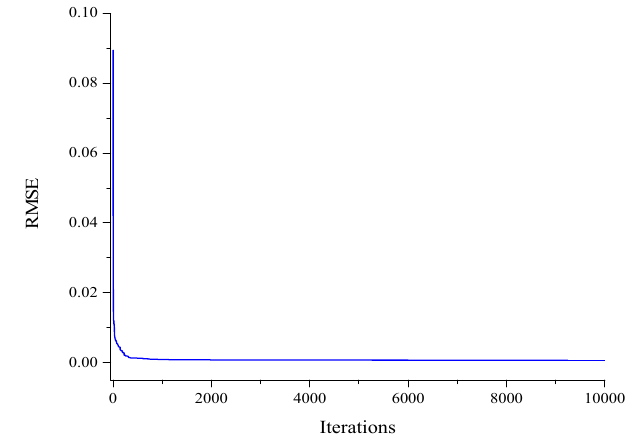
Figure 10. Convergence curve for the double-diode cell.